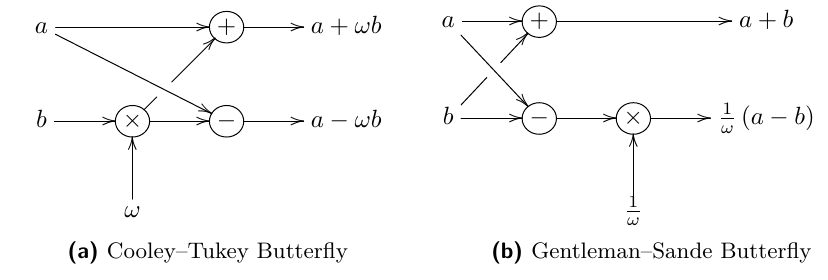
Figure 1: The “Butterflies” of Fast Fourier